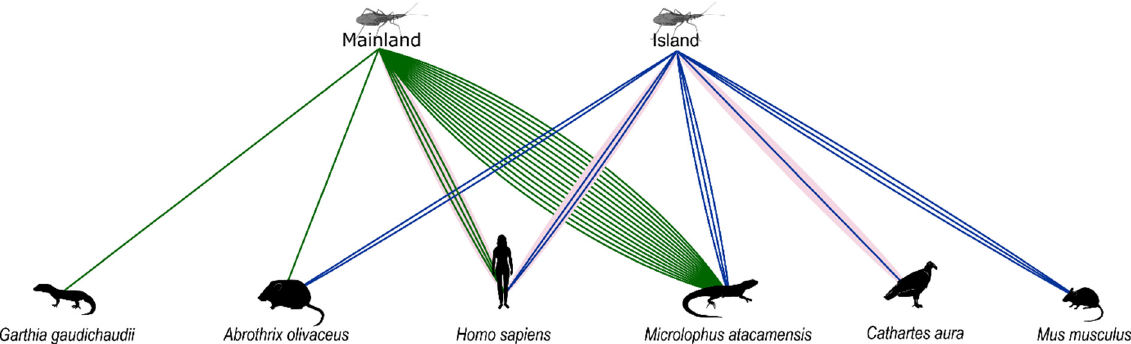
Figure 2. Blood meal sources of Mepraia parapatrica in two sites of Pan de Azúcar National Park, mainland (green) and island (blue). Each coloured line corresponds to an individual standard sequencing result. Light pink connections are NGS results. Six vertebrate species were detected; from left to right: the gecko lizard Garthia gaudichaudii , the sylvatic mouse Abrothrix olivaceus , Homo sapiens , the lizard Microlophus atacamensis , the vulture Cathartes aura and the common mouse Mus musculus .